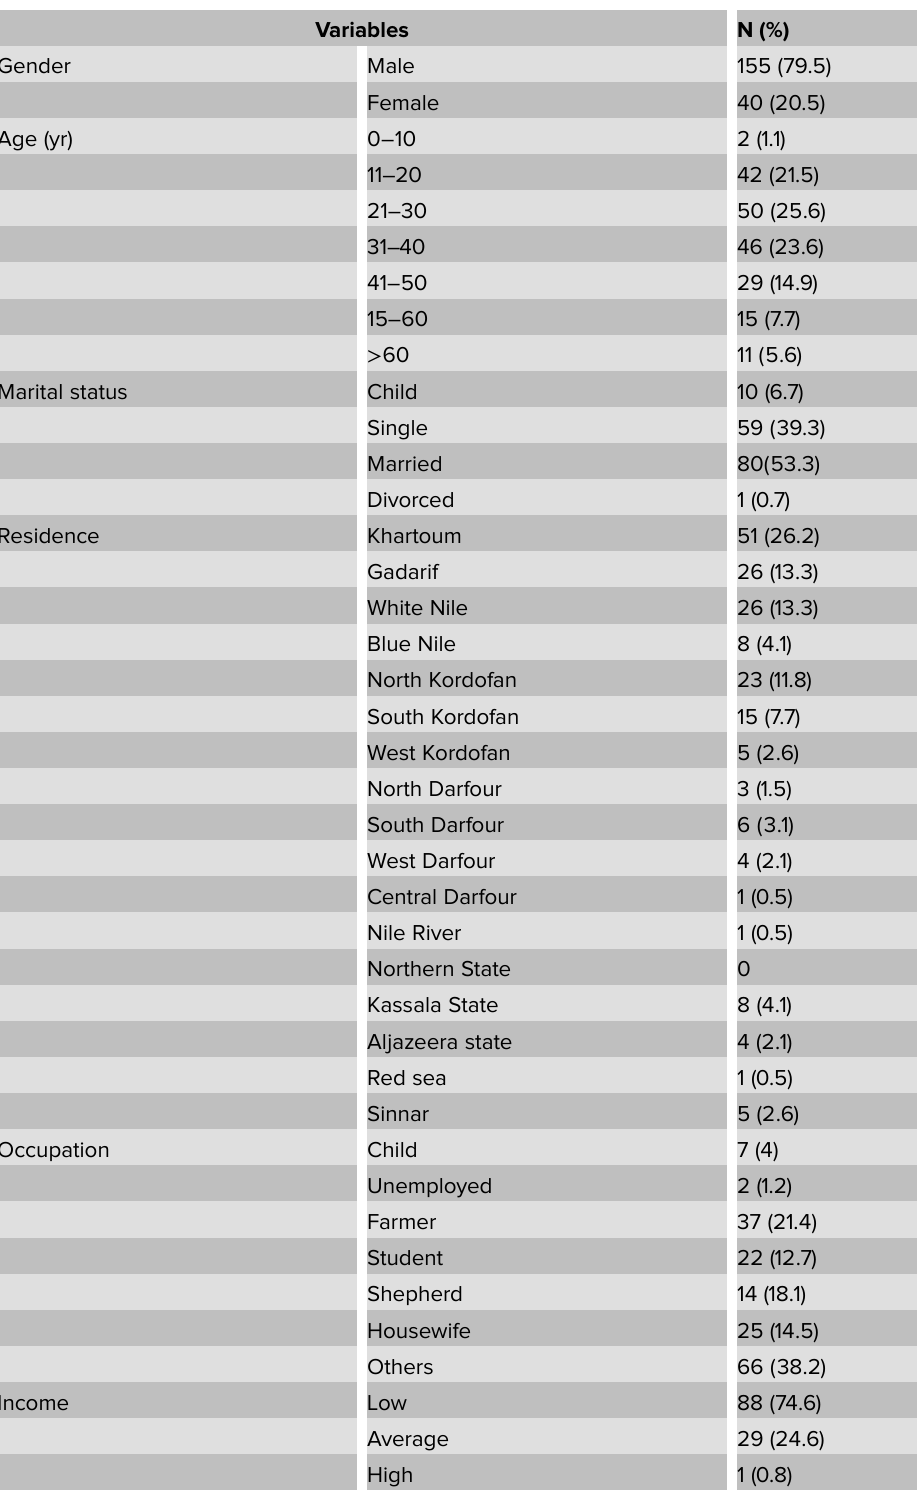
Table 1: Sociodemographic data of VL patients who were admitted to the